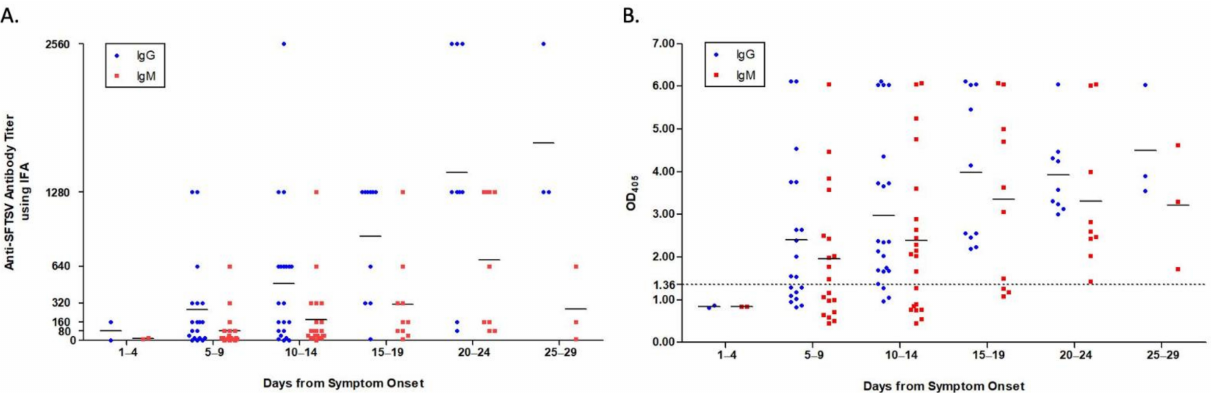
Figure 2. Scattered plot of antibody responses in patients with SFTS. Data are denoted as means. Both IgG and IgM were measured using IFA ( A ) and ELISA ( B